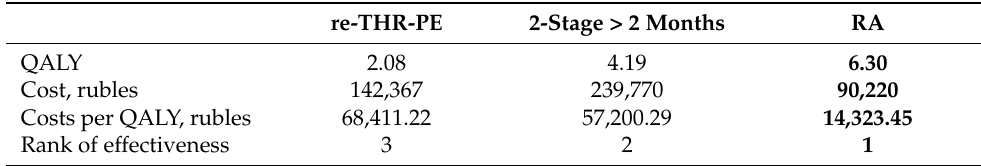
Table 4. Average costs for treatment methods in the retrospective group according to the deci- sion trees.